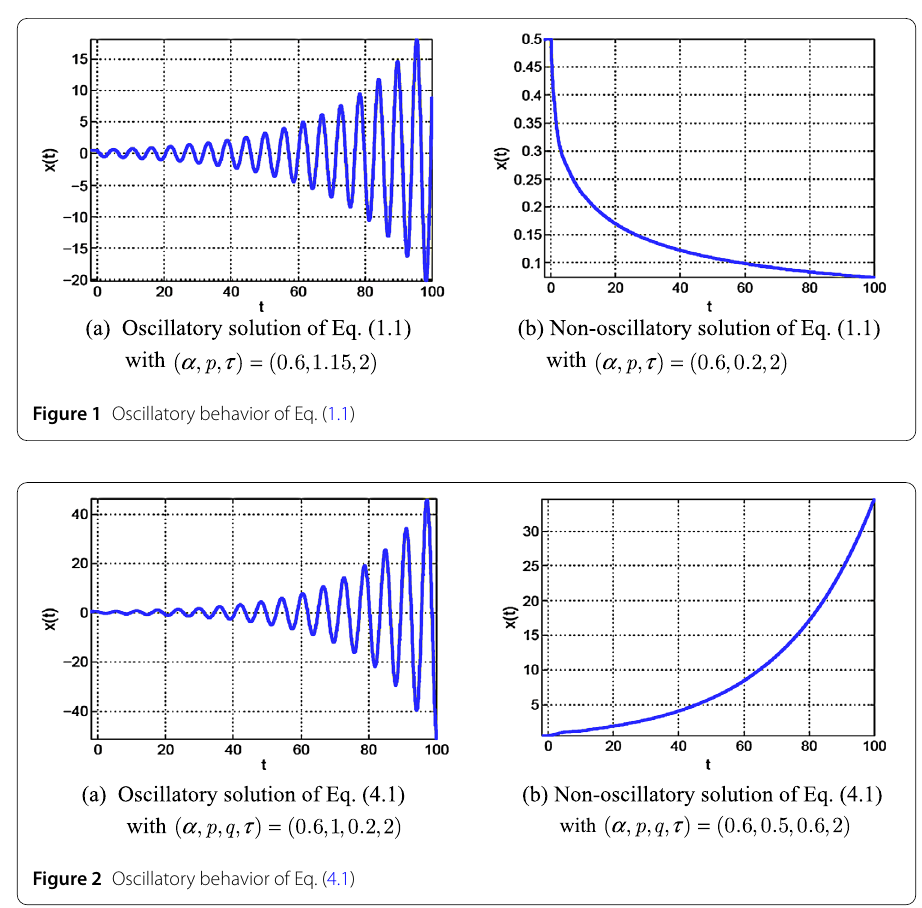
Figure 2 Oscillatory behavior of Eq.